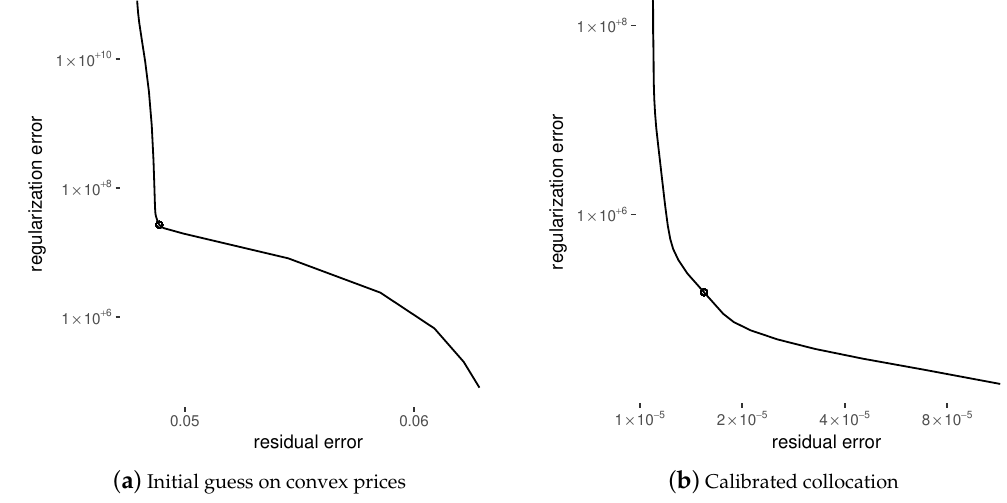
Figure 3. L-curves of the B-spline corresponding to the initial guess, and the calibration result on TSLA